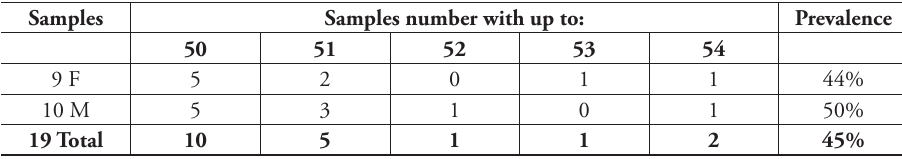
Table 1. B chromosome polymorphisms in Characidium alipioi . Samples: number of males (M) and females (F) analyzed. Prevalence: the total and sex-specific percentage of individuals carrying B chromosomes. Samples Samples number with up to: Prevalence 50